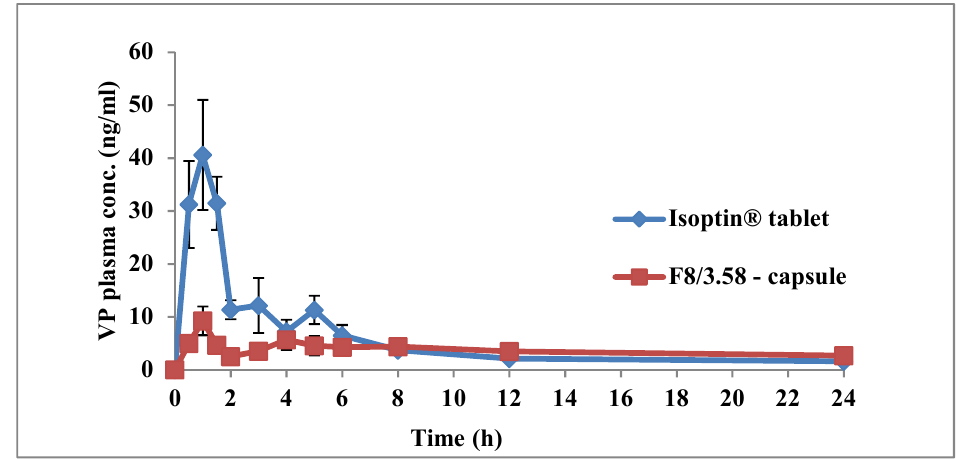
Figure 11. Mean ( ± SD) plasma VP concentrations following oral administration of Isoptin ® tablets and F8 / 3.58 beads filled capsules to six albino rabbits.